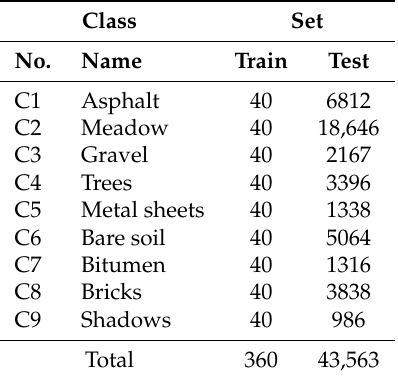
Table 3. Nine ground-truth classes in the ROSIS University of Pavia dataset and the number of training and test pixels used in the experiments. Class Set